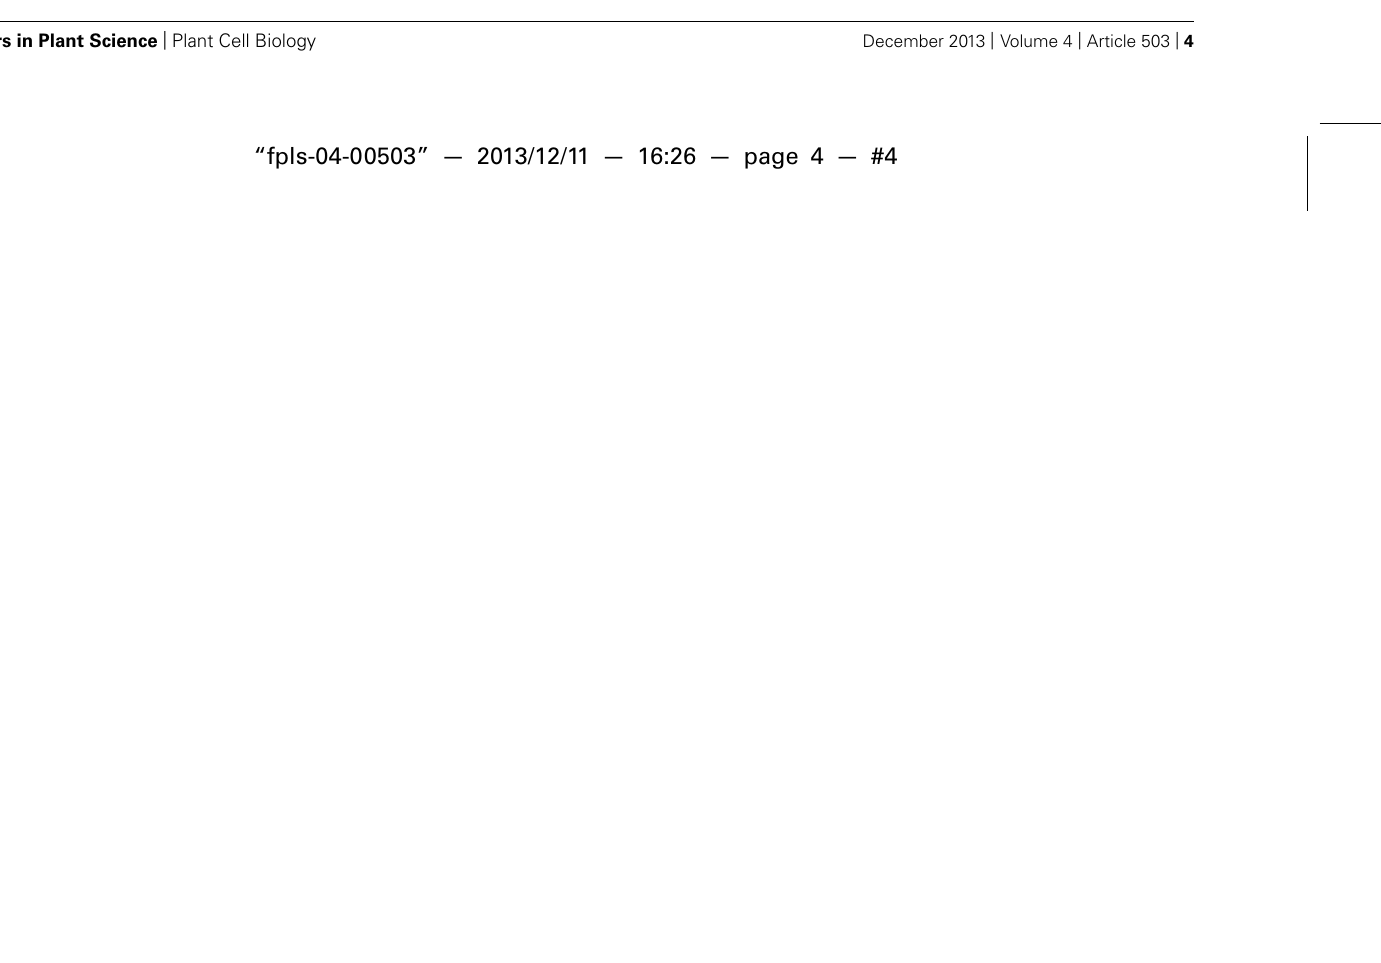
so that even short lived complexes can be detected whose existence is canceled out when a larger observation area is used (Wawrezinieck etal., 2005). (C) By varying the PSF width, a plot of transit time vs spot size can be generated that reveals free diffusion (green), or membrane heterogeneity caused by an actin meshwork (blue), or membrane domains